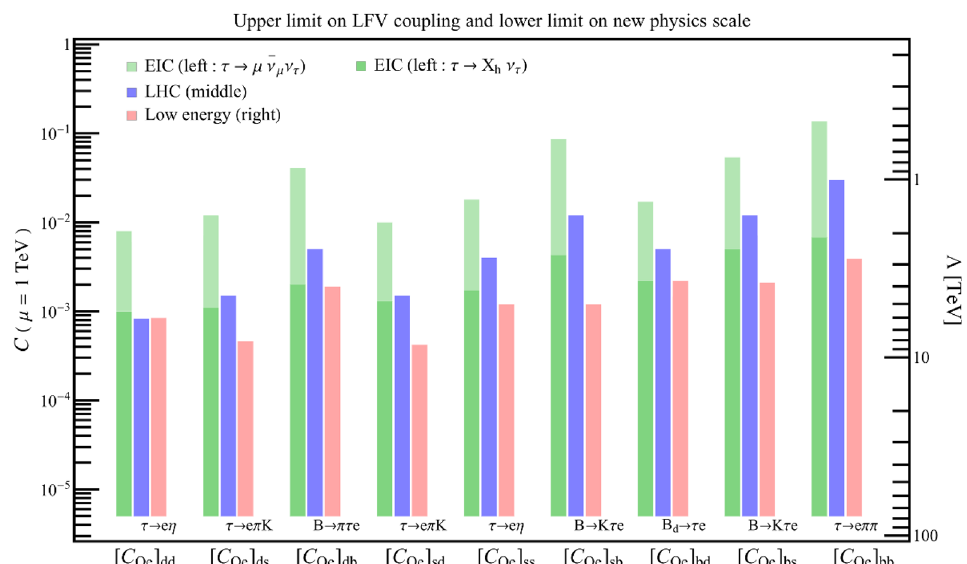
Figure 19 . Upper limit on C Qe (leftmost axis) and lower limit on new physics scale Λ (rightmost axis). For the EIC expected sensitivity, the light green bar corresponds to the result in table 7, while the dark green one represents the case in hadronic tau decay mode assuming (cid:15) n b = 0 in tables 3–5.